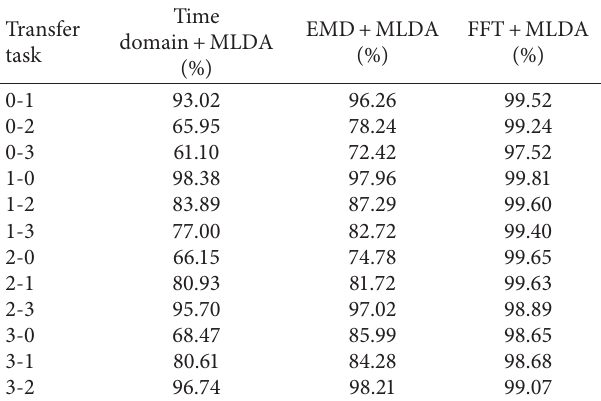
Table 3: Experimental results of different signal processing